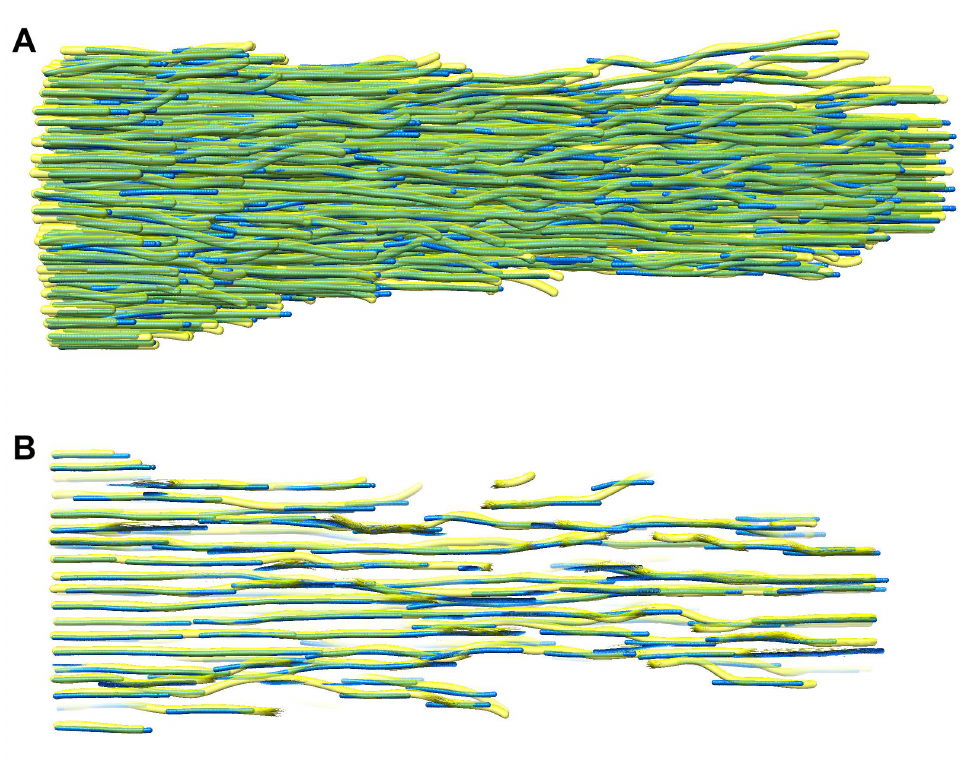
Figure 6. Automatically detected FSs (solid blue; this work) superimposed by the ground truth manually traced filaments (transparent yellow, [18]). ( A ) The green areas in this full-view rendering indicate good agreement because of the subtractive color mixing. ( B ) A slab consisting of 10 Z -slices, which is taken from the center portion of ( A ), provides a detailed view of the individual filaments. The FSs (blue) have been obtained from the 0.60 noise level simulated map (Figure 3B), which is closest